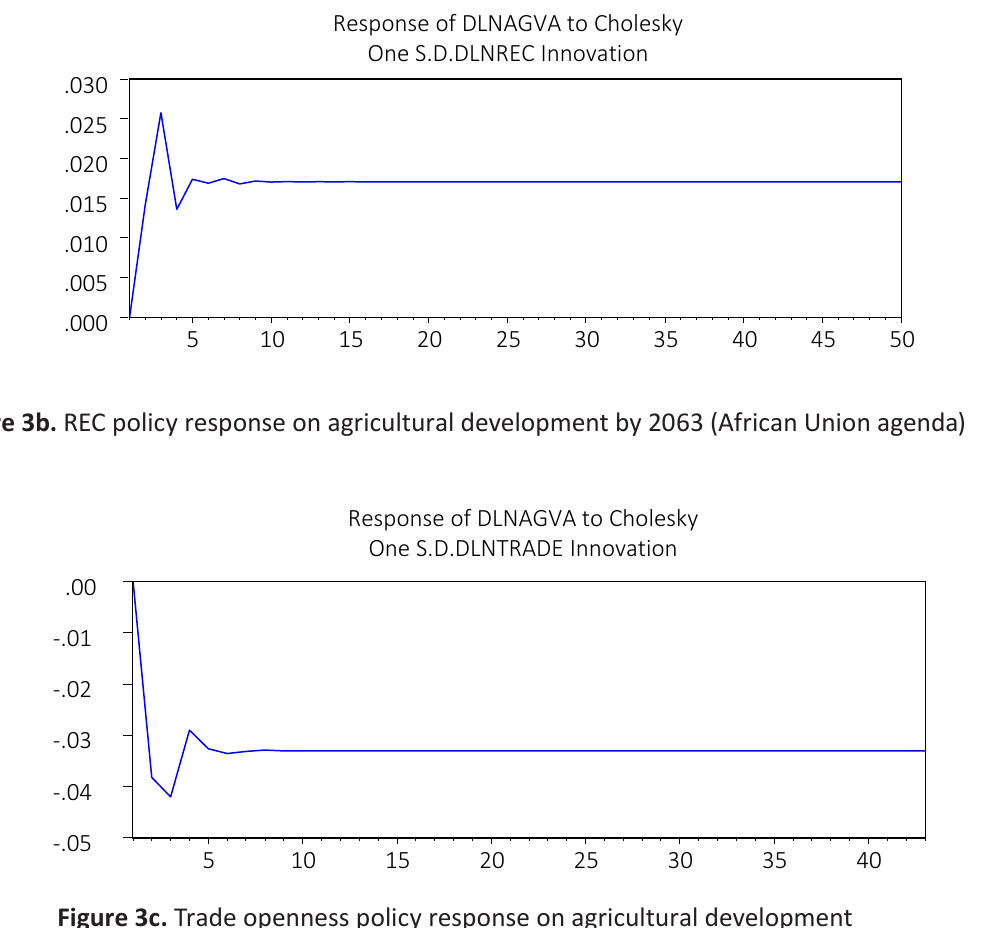
Figure 3c. Trade openness policy response on agricultural development by 2063 (African Union agenda)